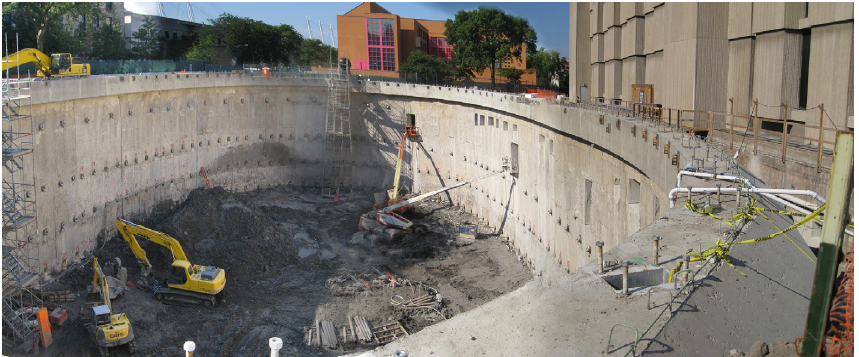
Figure 11: The site in summer 2009 - excavation of underground levels (© Halvorson and